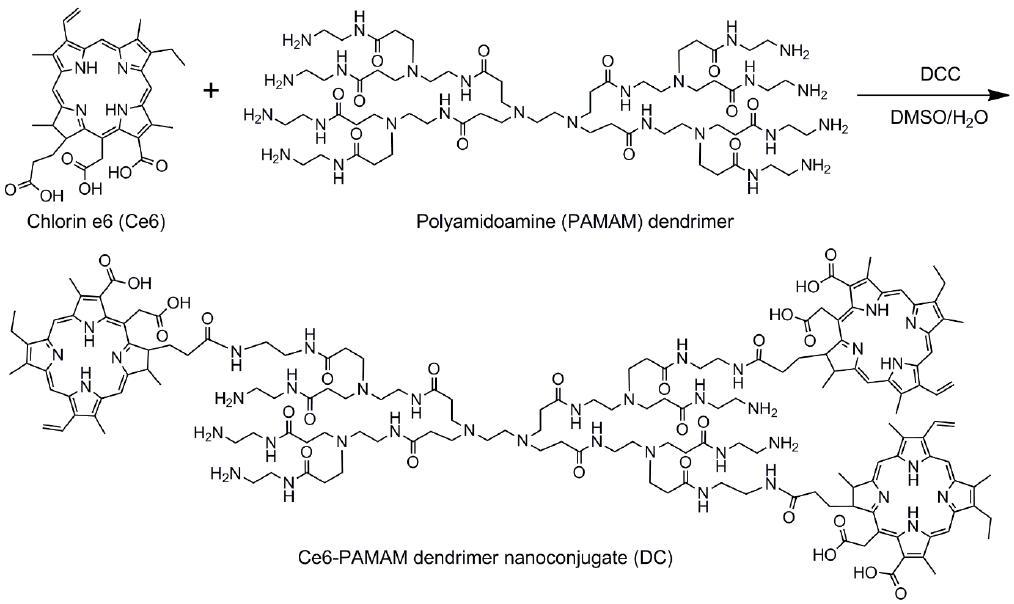
Figure 1. Schematic diagram of synthesis of hydrophilic Ce6-PAMAM dendrimer nanoconjugate (DC).